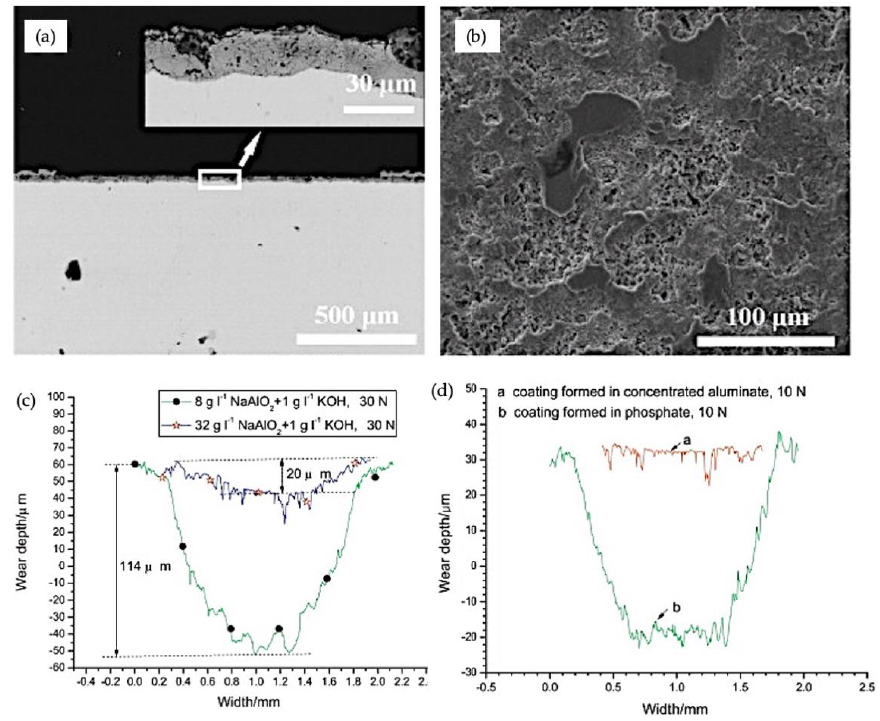
Figure 6. ( a ) The cross-section image of sliding bar impact on the coating surface formed in aluminate electrolyte [54]; ( b ) the central part of the wear scar on the PEO coating formed in aluminate electrolyte [54]; ( c ) the wear profile of the sliding test for PEO coatings produced in dilute and concentrated aluminate electrolyte under 30 N applied load [54]; ( d ) the wear profile of the sliding test for the PEO coating formed in concentrated aluminate electrolyte (red color) and the PEO coating formed in phosphate electrolyte (green color) under 10 N applied load [54] (Reproduced with permission number: 5046821419713, Elsevier).